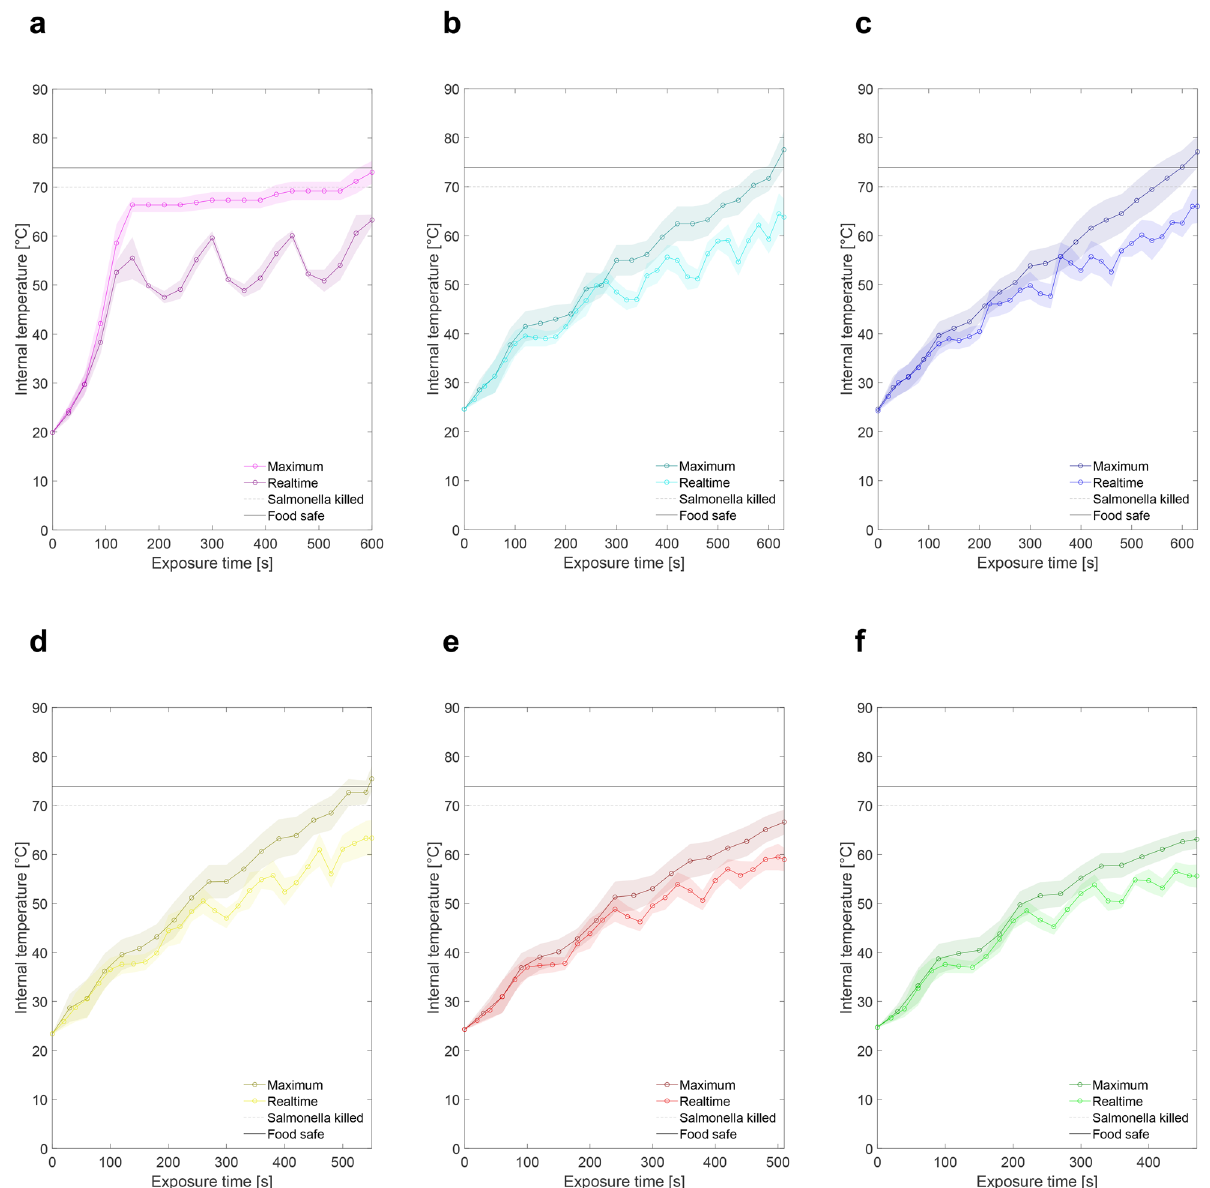
Fig. 5 Comparing fl uctuations in realtime internal temperature readings to maximum recorded internal temperature readings in laser- cooked printed chicken samples. Since the laser provides pulsed heating, regions of the food will cool unless they have direct beam exposure, which is why we are comparing realtime with maximum recorded temperature as a way of visualizing the ambient cooling taking place during the cook cycle. For the following test cases, a single printed layer of chicken was used (2.5 mm × 24 mm × 24 mm), a trochoidal pattern with six shells was used with a consistent circle radius (1.5 mm). The shape of the cooking pattern used for ( c – f ) was the same with the only variation being the speed of the moving laser. The density of the circles for each successive ring decreased by 0.5 rev/mm for ( c ) while remaining constant at 12 rev/mm for ( b ). Shaded region for each line shows standard error from eight thermocouples in a single sample. a Cycle time of 149 s (2:29) with four repetitions (9:56). b Cycle time of 630 s (10:30). c Cycle time of 630 s (10:30). d Cycle time of 550 s (9:10). e Cycle time of 511 s (8:31). f Cycle time of 471 s (7:51). Shaded region for each line shows standard error from eight